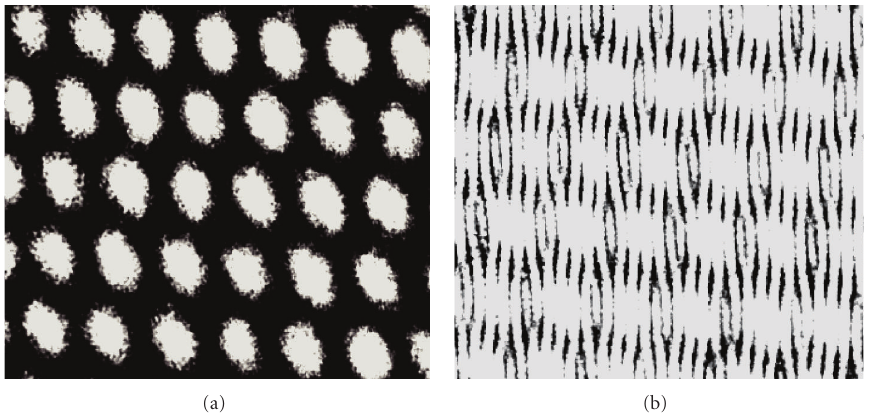
Figure 12: (a). Interferogram recorded with the Mach-Zehnder interferometer configuration, (b) Formation of fork fringe pattern when fourth beam is added, indicating the presence of vortex dipole arrays.